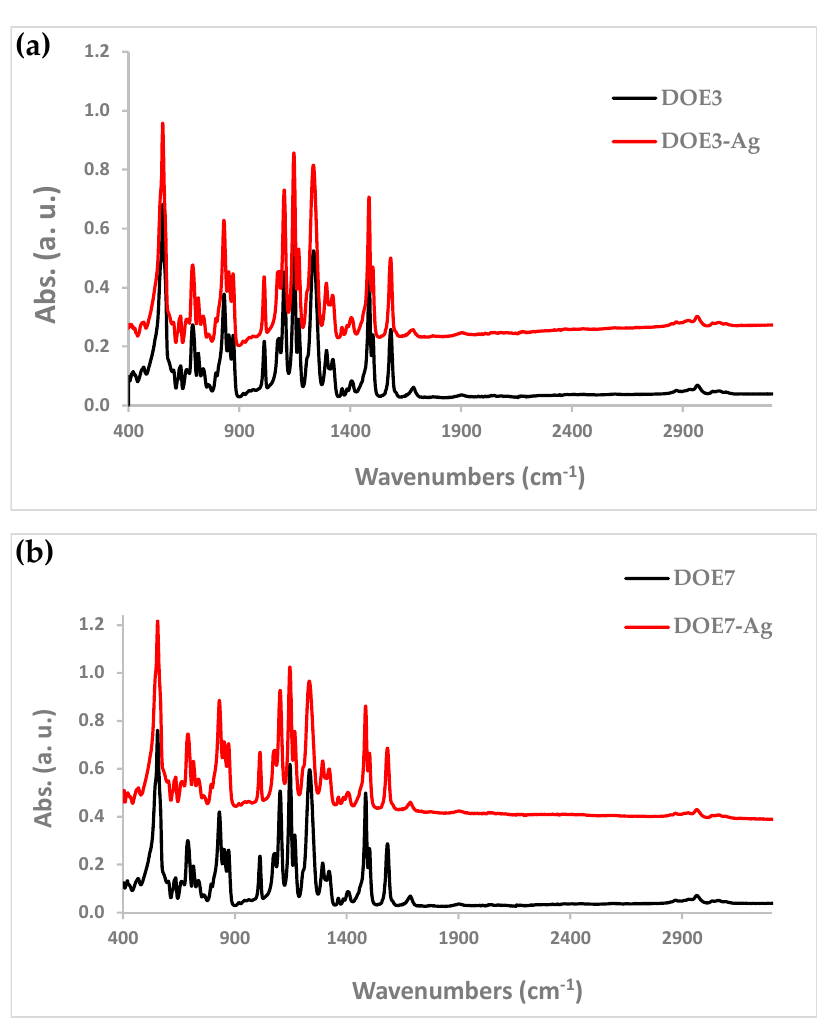
Figure 8. FTIR spectra of ( a ) DOE3 and ( b ) DOE7 samples before and after Ag deposition. The X-ray diffraction spectra for uncoated PSU and Ag-coated PSU electrospun membranes are shown in Figure 9. The XRD pattern of polysulfone exhibited a broad peak centered at around 2 θ = 17.9 ◦ , which indicated an almost amorphous structure. The diffraction peak at 38.1 ◦ , which corresponds to the (111) crystalline plane of the silver particles [29,30], was present throughout all coated samples together with the broad pattern associated with the PSU amorphous phase.